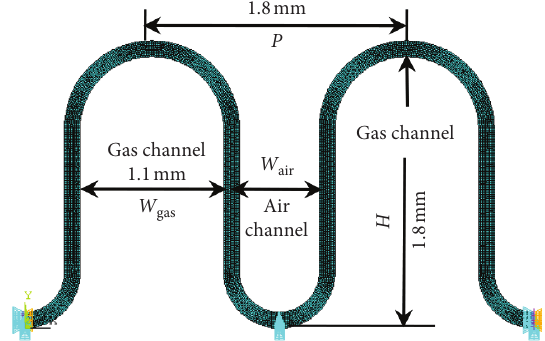
Figure 2: Physical model and constraint